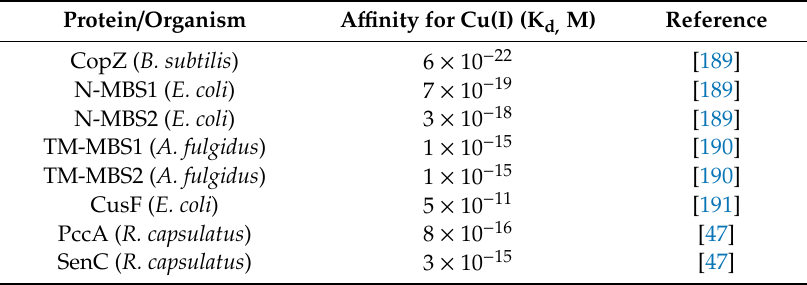
Table 3. Cu a ffi nities of bacterial Cu-chaperones and metal-binding sites (MBS) of P 1B -type ATPases. N-MBS refers to the N-terminal MBS and TM-MBS to the membrane-integral MBS of P 1B -type ATPases. Bacterial P 1B -type ATPases often have two